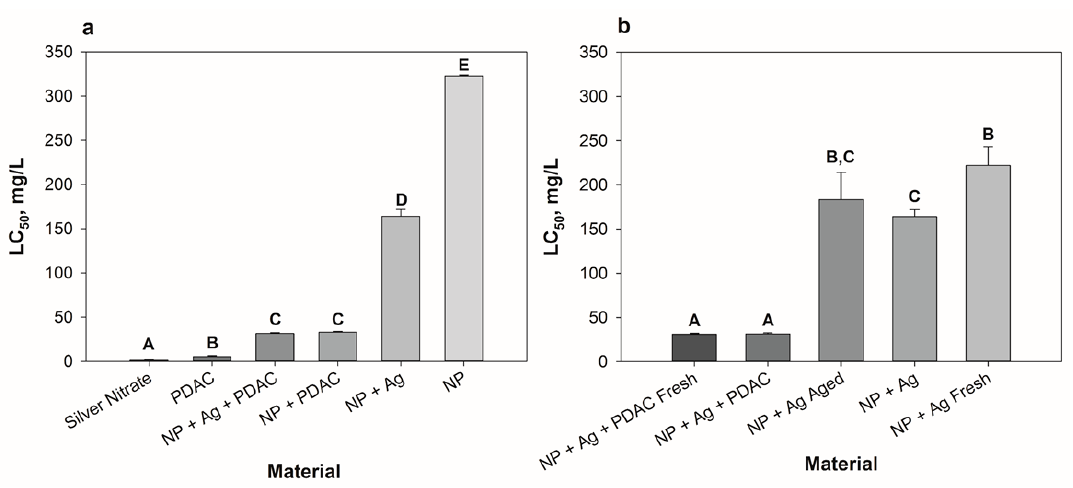
Figure 2. LC 50 ′ s for nanoparticles and components ( a ) and dialyzed samples ( b ) with standard error of two experimental replicates with 12 embryos exposed at each concentration in each replicate test (24 embryos per concentration total). Significant differences between LC 50 values are indicated with a change in letter above the bar.